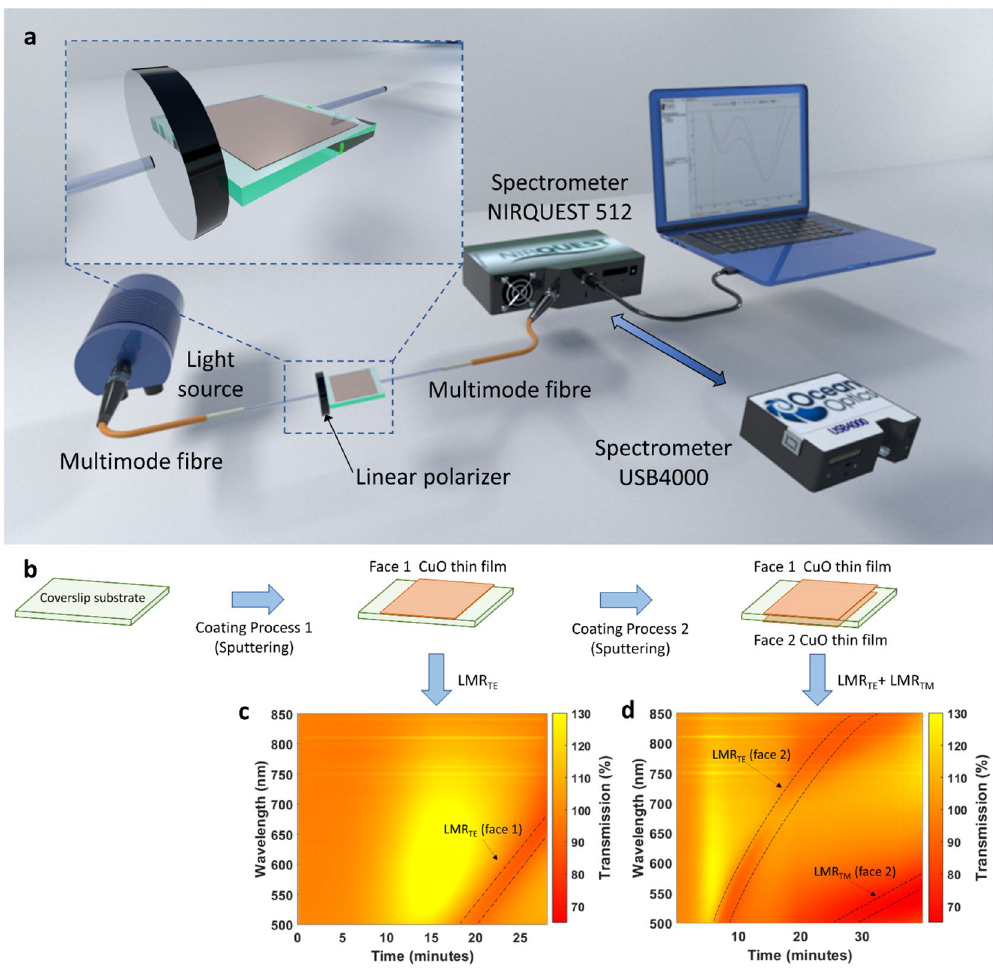
Figure 1. Fabrication and characterization of the sensor. ( a ) Experimental setup where a coverslip for a microscope slide is excited with light from a broadband source. ( b ) Both the upper face (face 1) and the lower face (face 2) of the coverslip are deposited with a CuO thin film. ( c ) Colour map representing the transmitted light as a function of time during the deposition of a CuO thin film on face 1 of the coverslip. ( d ) Colour map representing the transmitted light as a function of time during the deposition of a CuO thin film on face 2 of the